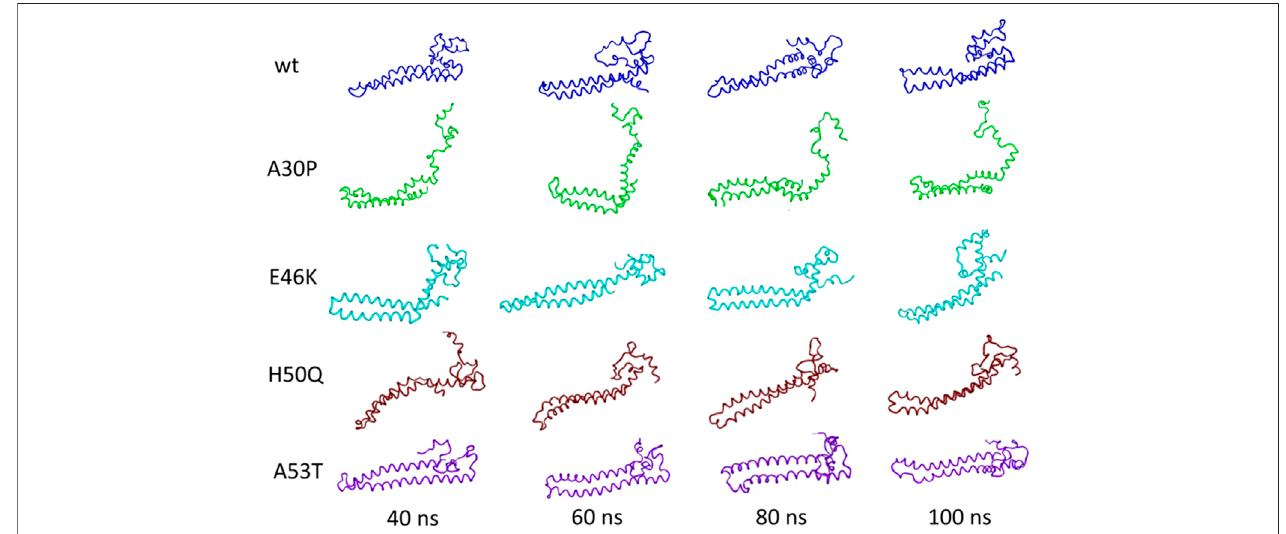
FIGURE 6 | Tertiary structure of the initial NMR conformations of the mutants containing a signi fi cant percentage of α -helices changes during MD. Figure modi fi ed from Tsigelny et al. (2015).